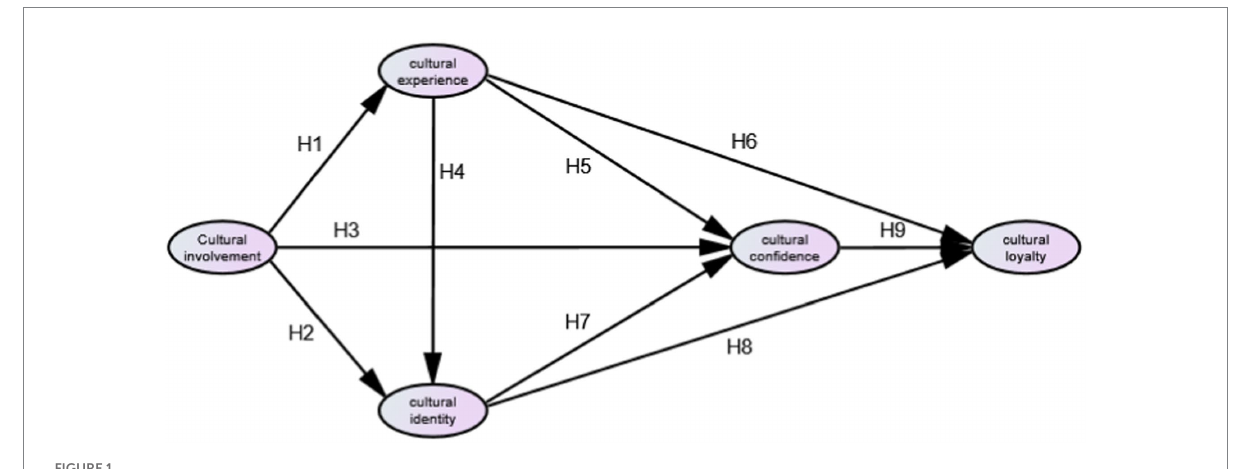
FIGURE 1 The structure